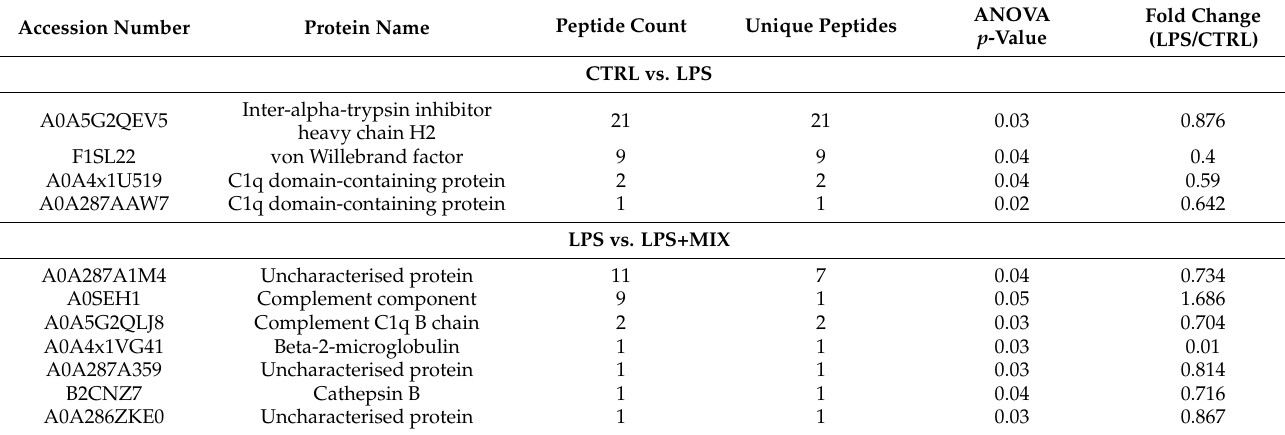
Figure 3. Principal component analysis (PCA) scatterplot of the three experimental groups. Groups are: CTRL, the control group; LPS, the LPS-challenged group; LPS+MIX, the LPS-challenged supple- mented with arginine, branched-chain amino acids (BCAA) and cystine mixture group. Differences are highlighted in Table 4. The comparison between LPS and CTRL groups revealed an accumulation of four proteins in the CTRL group. These proteins are inter-alpha-trypsin inhibitor heavy chain H2, von Willebrand factor, and two C1q domain-containing proteins. The comparison between LPS+MIX and LPS groups revealed seven proteins showing differential accumulation. Except for Complement component C8A, all proteins had a higher concentration in the LPS group. Table 4. Differential protein abundance in serum on day 35 between CTRL and LPS groups, and LPS and LPS+MIX